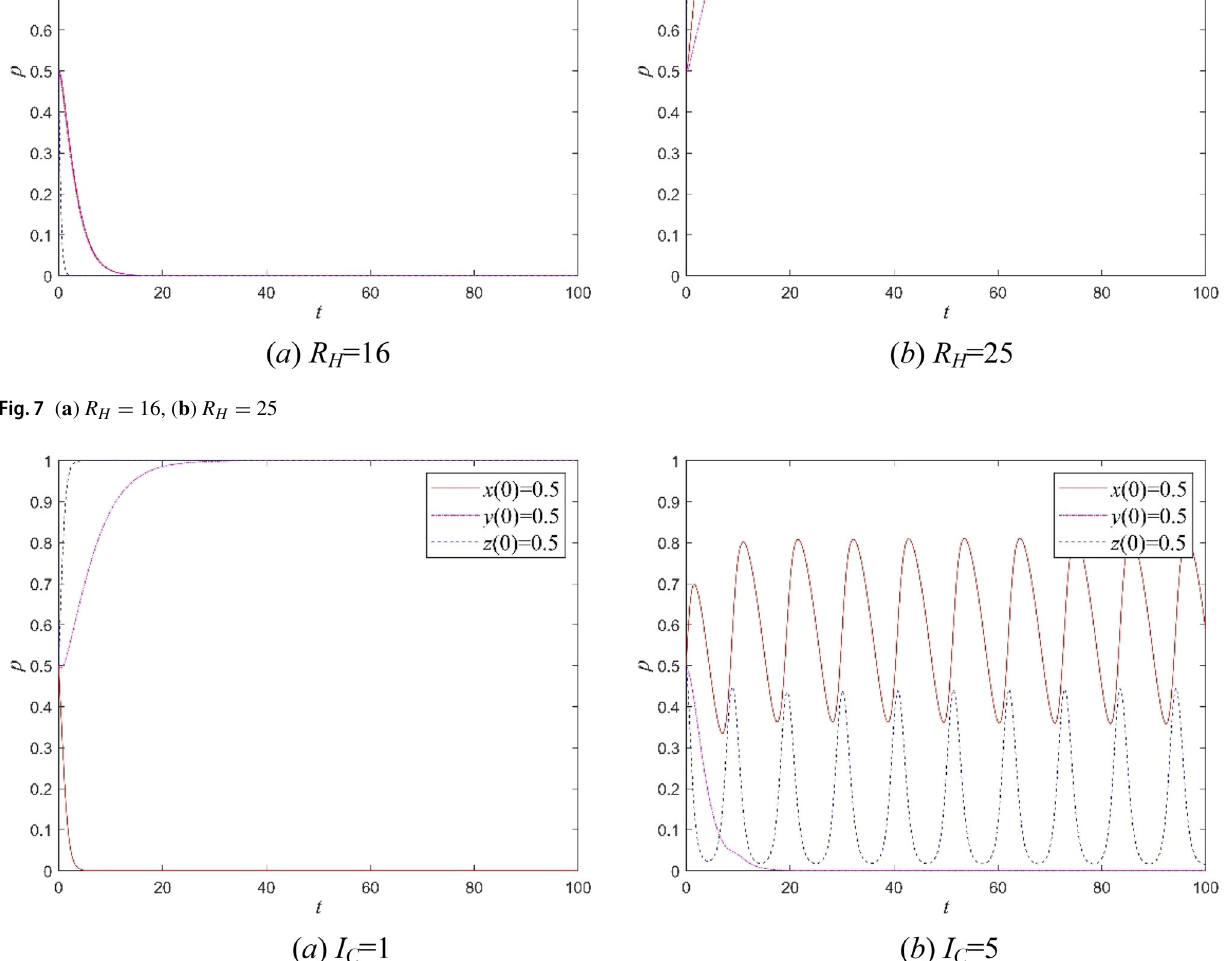
Fig. 8 ( a ) I C (cid:2) 1, ( b ) I C (cid:2)